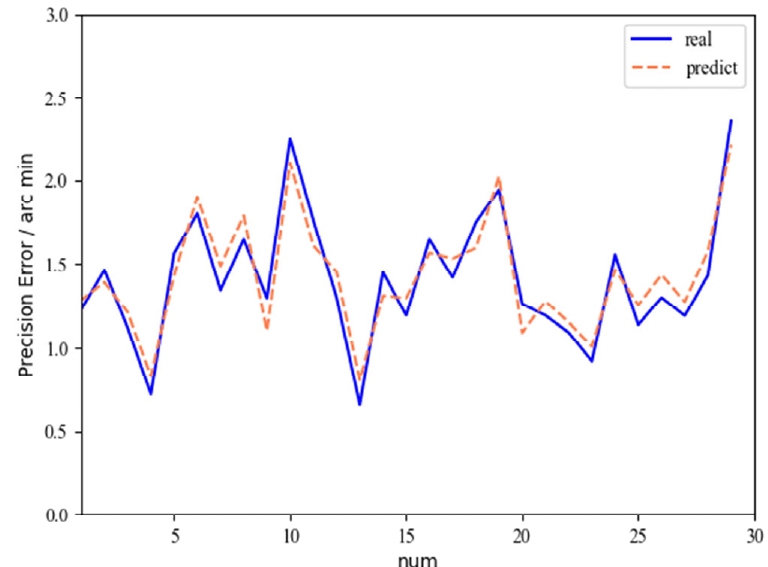
Figure 7. Prediction result of transmission error sample of RV-40E-121 reducer.